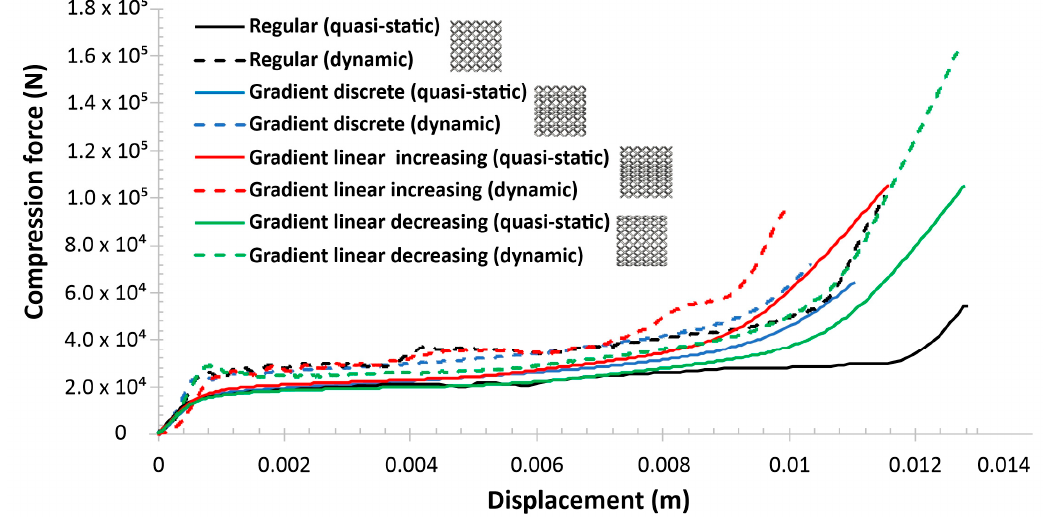
Figure 19. Comparison of compression force history plots obtained in quasi-static and impact compression tests.